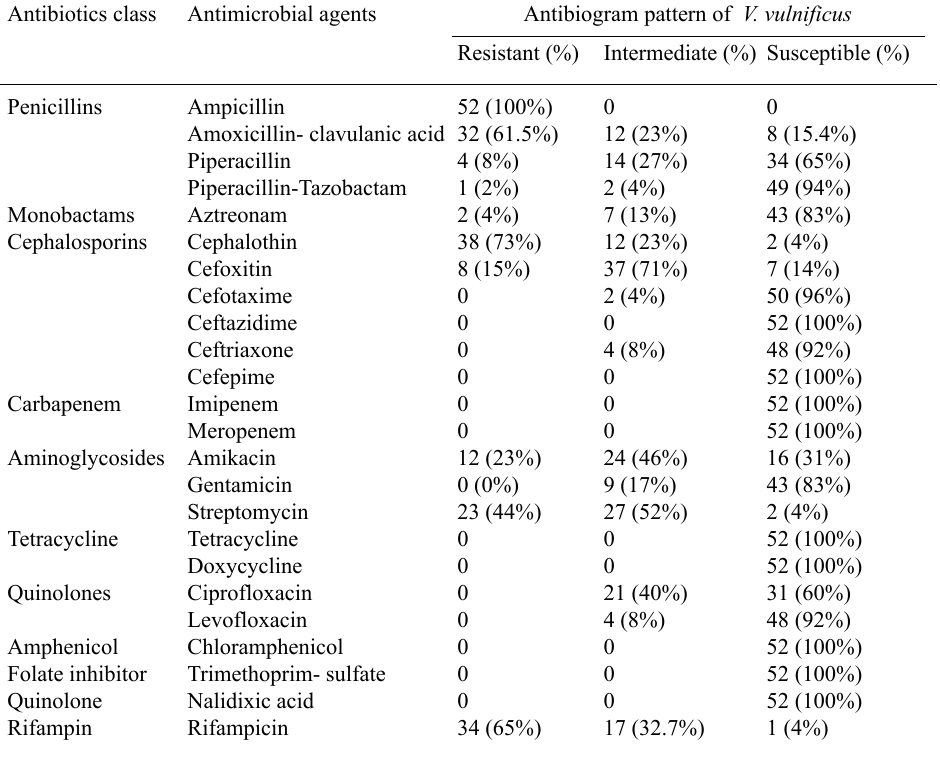
Table 2. Results of antibiotic susceptibility testing performed on 52 V. vulnificus